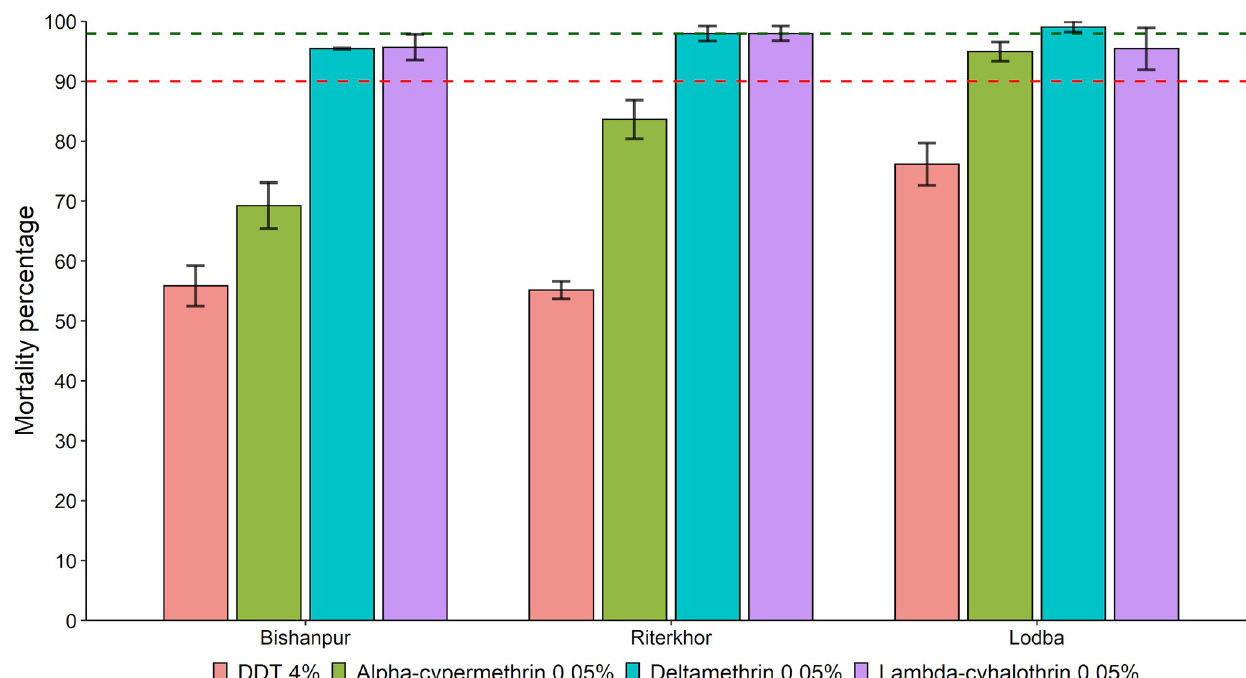
Fig 6. DDT-pyrethroid cross-resistance in P . argentipes from the selected IRS and non-IRS villages. The error bars represent the standard error of the mean. The green-dashed intercept represents the level of 98% mortality; the red dashed intercept represents the level of 90% mortality.